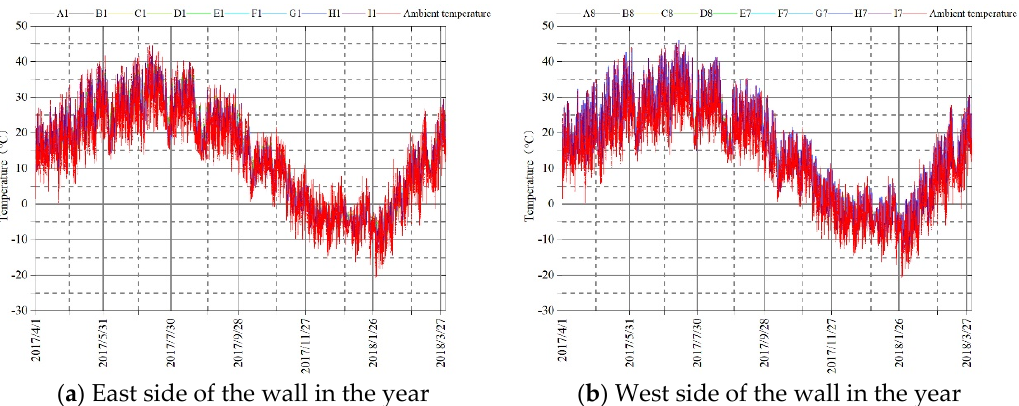
Figure 19. Temperature change characteristic on the wall in the year (1 April 2017–31 March 2018).